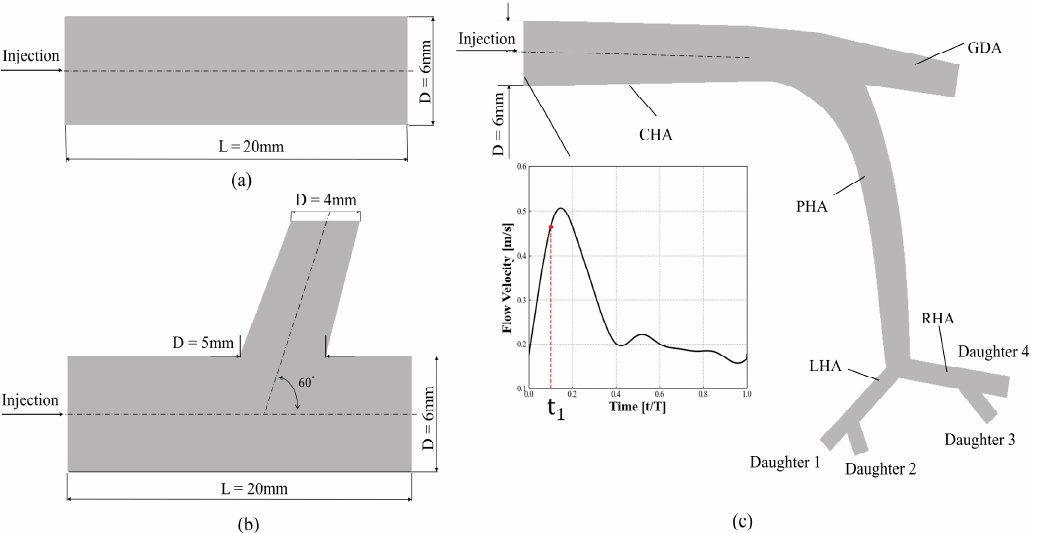
Figure 1. ( a ) Straight vessel geometry; ( b ) bifurcated blood vessel geometry; ( c ) a representative hepatic artery system and the velocity waveform in CHA, t1(=0.1 (t/T)) is the injection time.